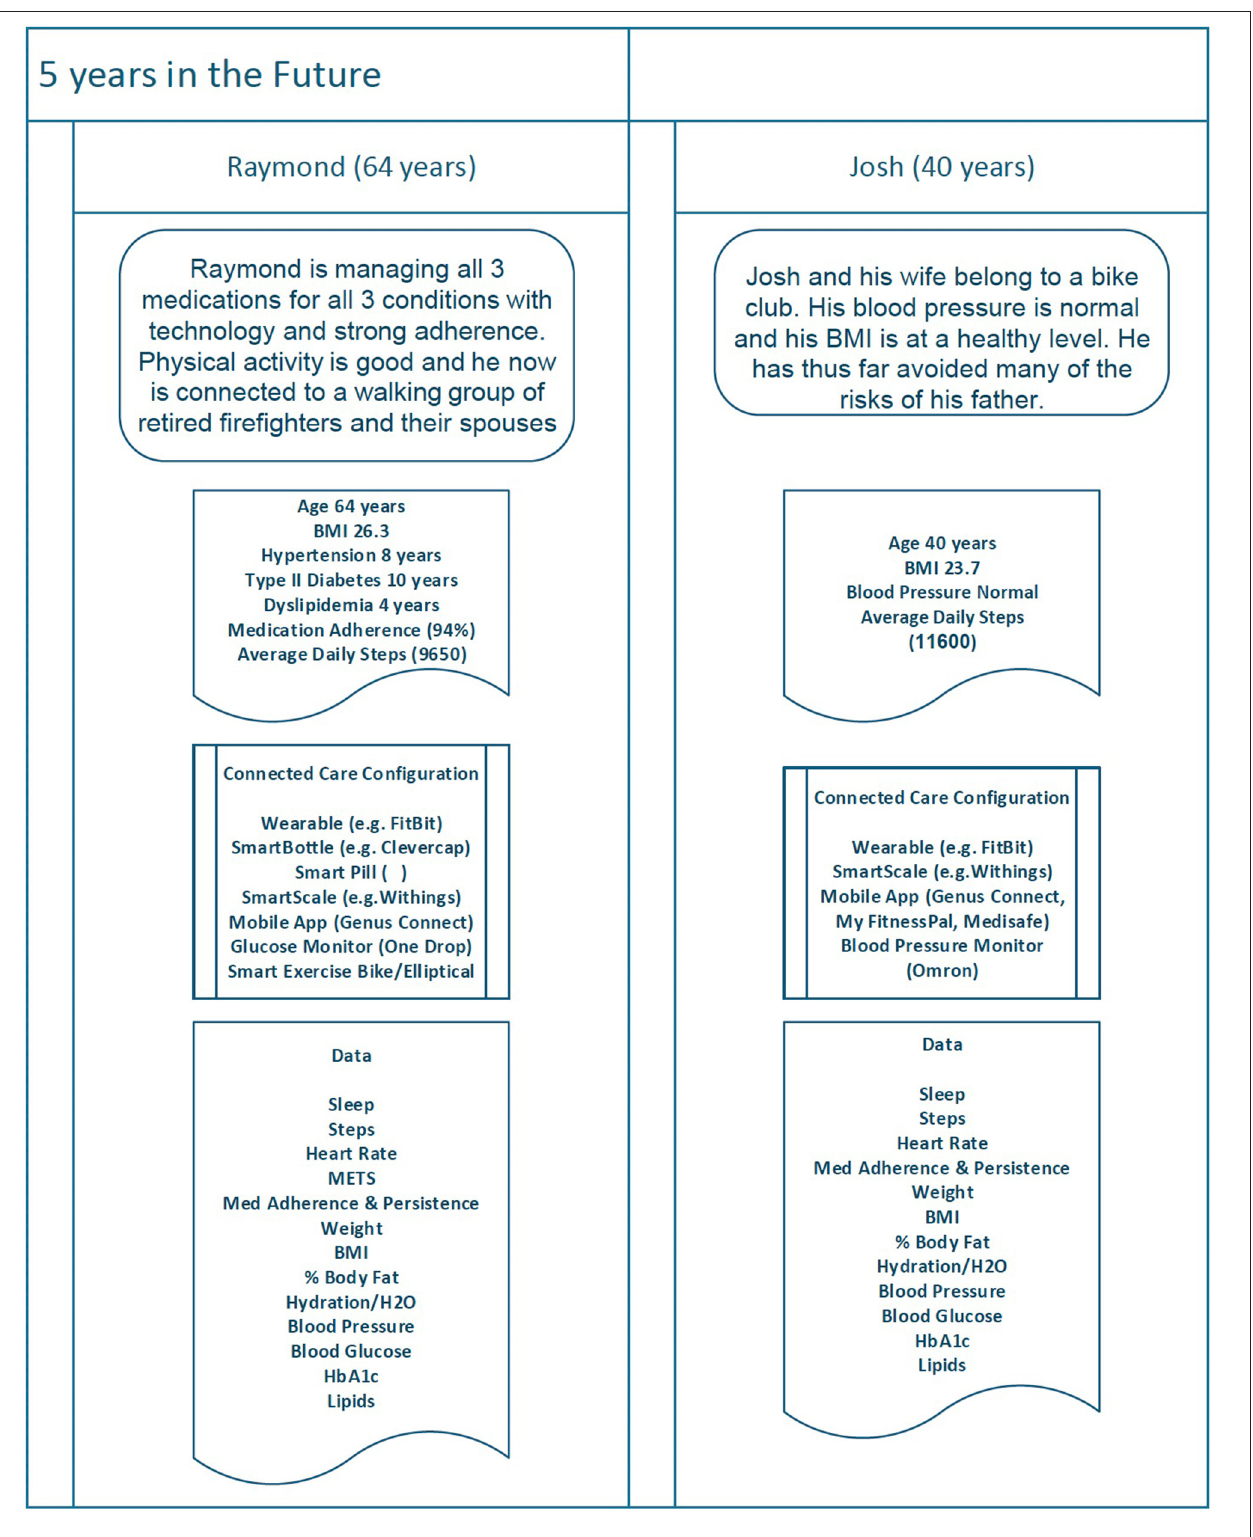
FIGURE 4 | As technology improves and both Raymond and Josh transition to maintenance of goals, they continue to monitor their data using a variety of connected devices and make behavioral adjustments in order to achieve desired outcomes.